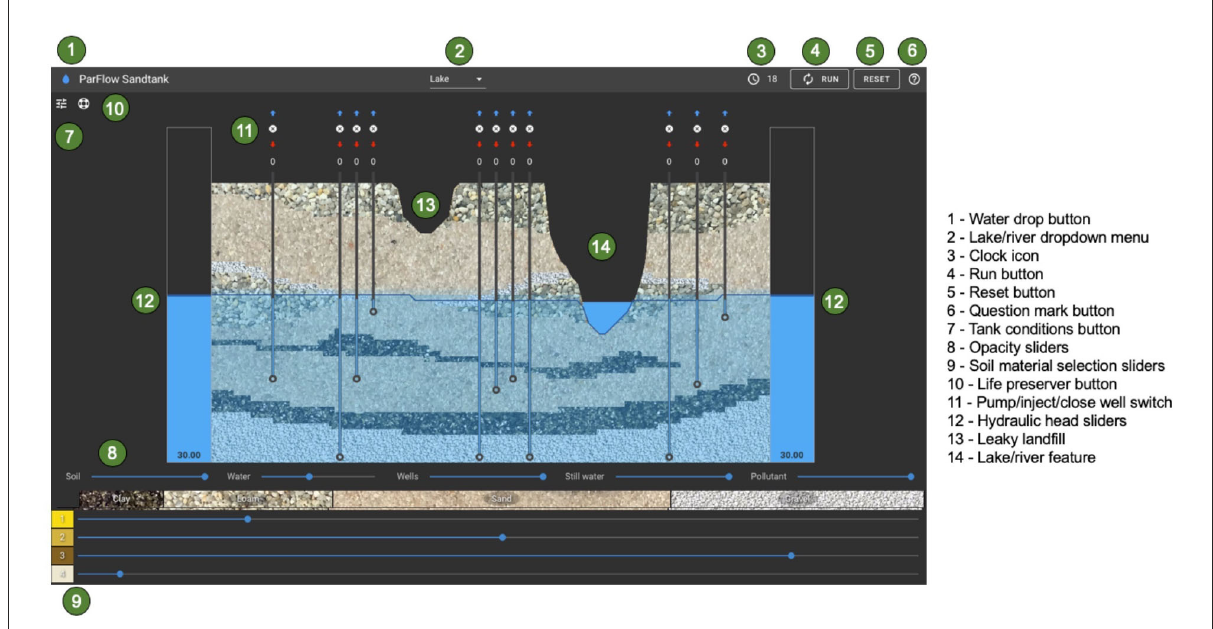
FIGURE3 Feature identification for the ParFlow Sandtank (also found in user